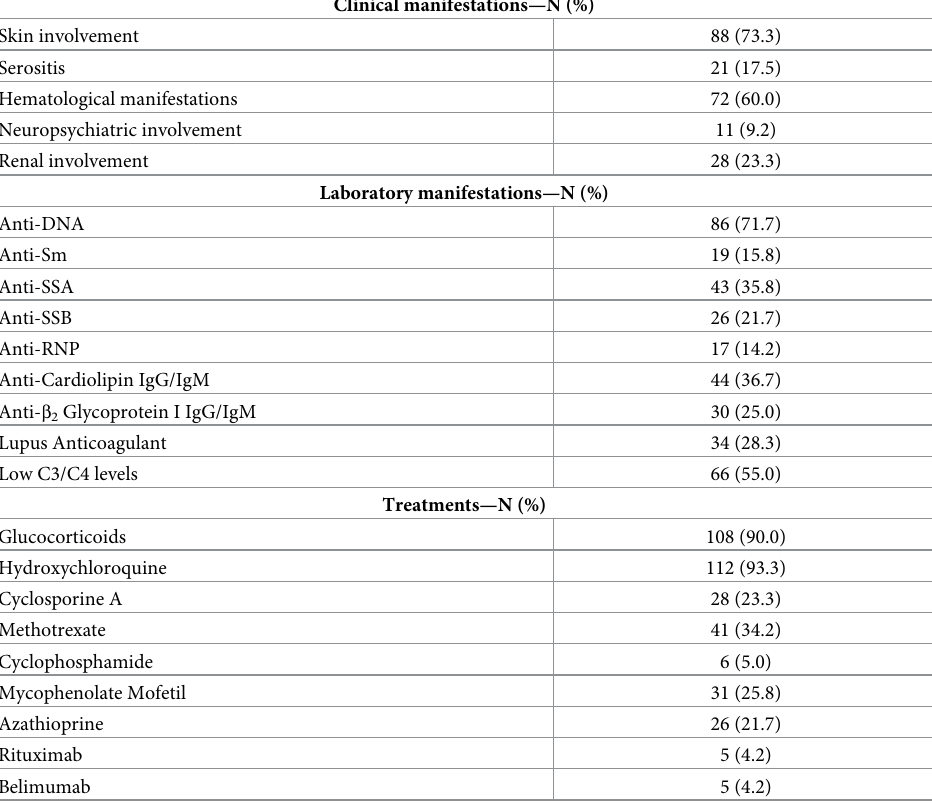
Table 1. Demographic features, clinical and laboratory manifestations and treatment of 120 SLE